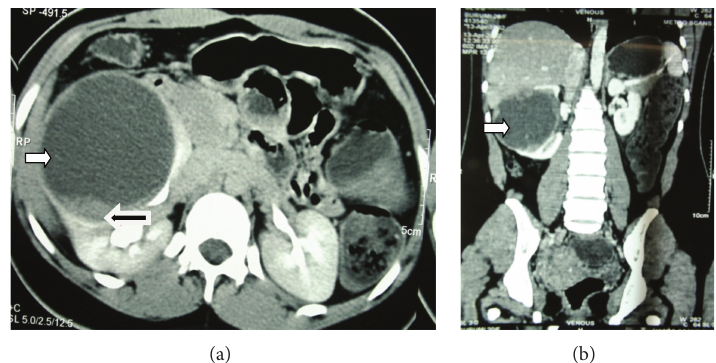
Figure 2: Contrast enhanced CT scan of the abdomen and pelvis in patient 1 with (a) axial section and (b) coronal section showing a large predominantly cystic (white arrow) right renal mass measuring 9 × 8 × 8cm with solid areas (black arrow).